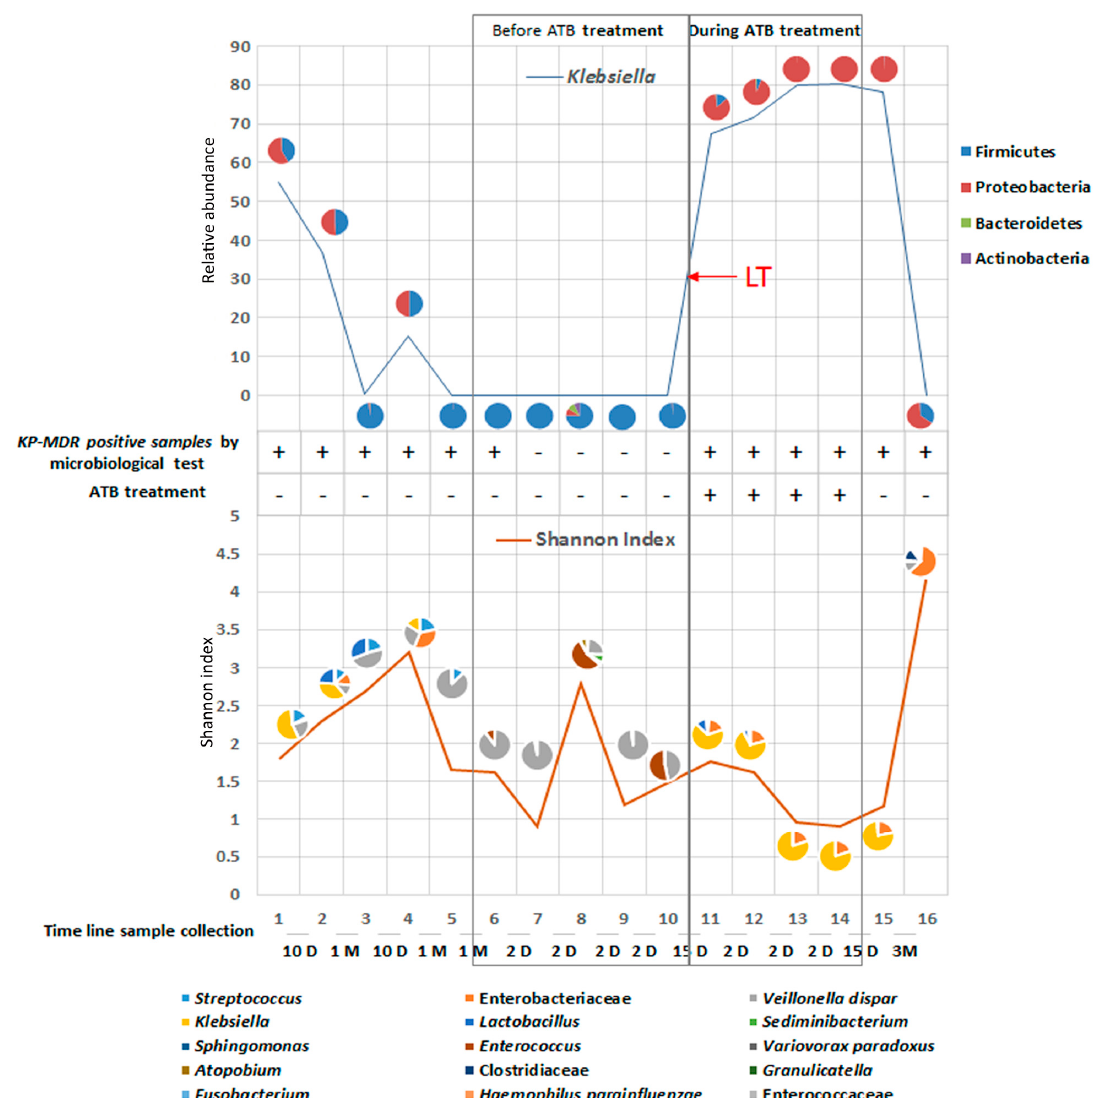
Figure 1. A combined approach of metagenomics-based gut microbiota profiling and culture-based MDR KP tracing pre- and post-transplantation. The upper graph shows relative abundance of Klebsiella during the microbiota profiling sample timeline, within the context of phyla distribution at each sampling point. The lower graph shows Shannon biodiversity index and species/family distribution during the timeline. The central table reports MDR K. pneumoniae isolations by culture-based microbiological methods and the antibiotic (ATB) treatment. The bottom dashed line indicates the time between each sample. D, days; M, Months. The arrow indicated the date of the liver transplant (LT). After one month, Klebsiella declined to 0.4% and Firmicutes increased to 98% of the microbiota. In these samples, the SI increased from 1.5 to 3; as Klebsiella distribution decreased until undetected, month, Klebsiella levels increased, reaching 15% with a fluctuating pattern. At this point, the